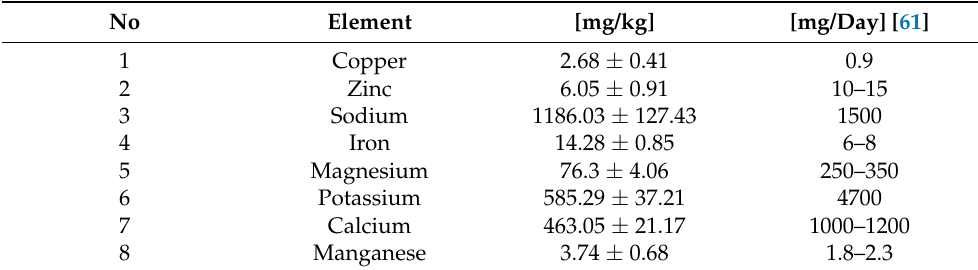
Table 5. Elemental composition of a purified preparation of the pulp of medlar (MF + WF) [mg/kg] and daily requirements for adults